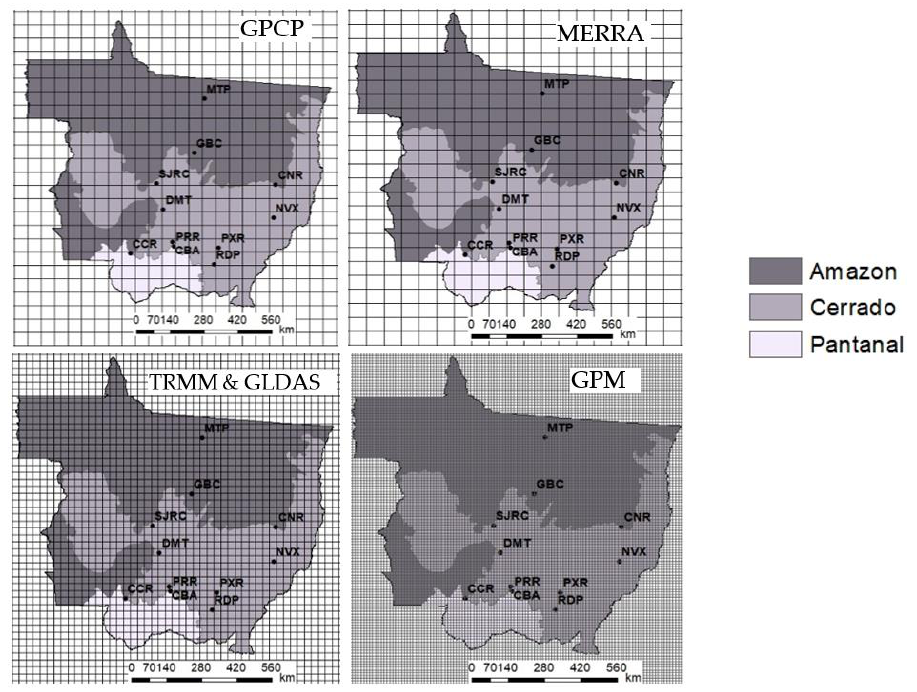
Figure 2. Spatial representation of the weather stations locations and the grid resolution (as shown in Table 2) of the precipitation products.